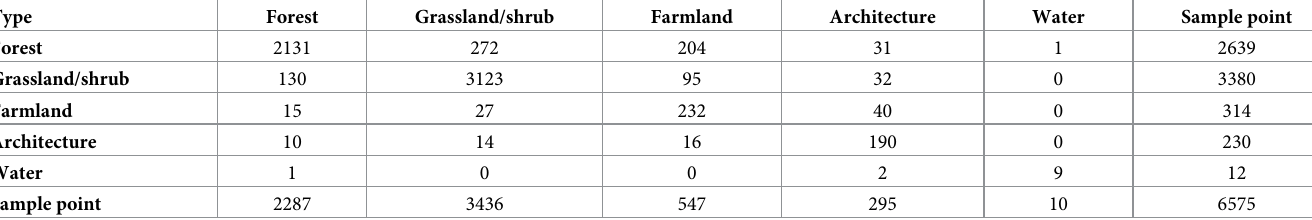
Table 5. Confusion matrix for the object-oriented classification of Longmen